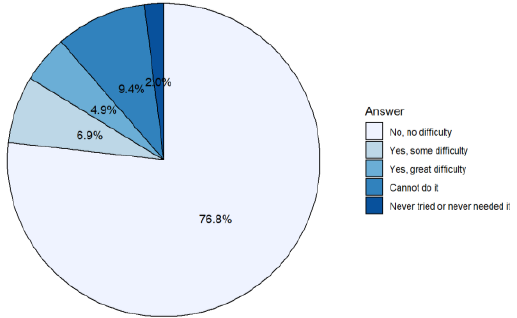
Figure 3. Shopping Difficulty (%) in the elderly population. Source: compiled by the authors based